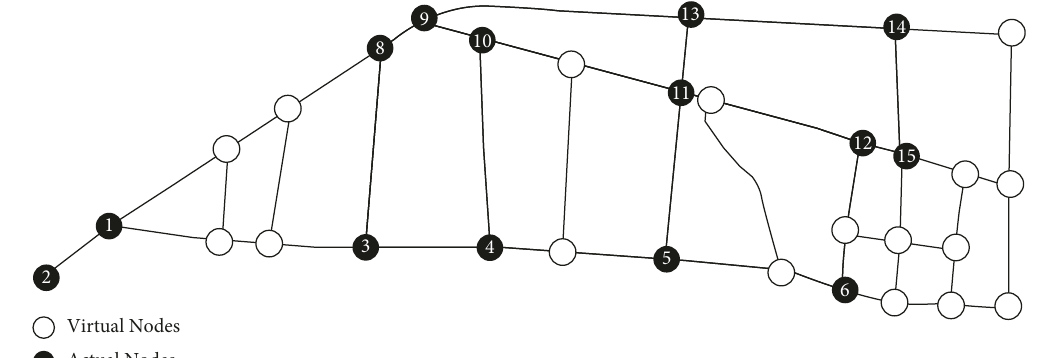
Figure 5: Simplified road network map of Yicheng County.